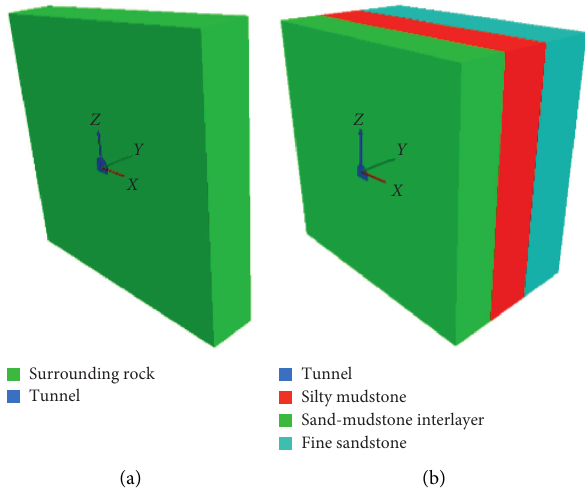
Figure 6: Three-dimensional model. (a) Single-rock layer. (b) Multiple-rock layer.